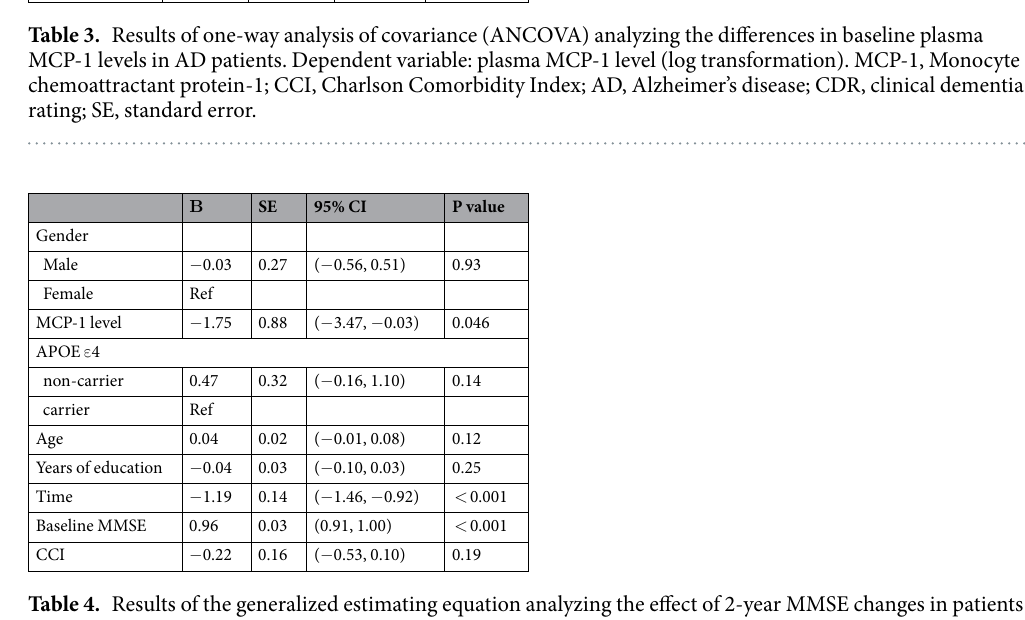
(Supplementary Table 1). Second, Table 4 shows the generalized estimating equation (GEE) analysis of two-year MMSE changes adjusted for age, years of education, gender, time, APOE ε 4 carrier status, baseline MMSE scores, and CCI. The GEE analysis revealed that the baseline MCP-1 level was significantly correlated with the 2-year MMSE changes (B = − 1.75, 95% CI = − 3.47 to − 0.03, p = 0.046). The Genetic Effects of the CCL2 and CCR2 Genotypes on the Plasma MCP-1 Levels. Table 5 shows the distribution of CCL2 and CCR2 genotypes in AD patients, MCI patients, and control subjects. The genotype distributions of CCL2 rs1024611 and CCR2 rs1799864 were in Hardy-Weinberg equilibrium (p = 0.1 and 0.46, respectively). The genotype distributions of these two SNPs were similar among the three patient groups (AD, MCI, and controls), suggesting no association between the CCR2/CCL2 polymorphisms and AD/MCI risk. The average MCP-1 levels were similar among the different genotypes of CCL2 rs1024611 in all groups of participants (Fig. 1, left side). However, the A allele of CCR2 rs1799864 appeared to exert an additive effect on the plasma MCP-1 levels, with the highest levels observed in the AA genotype, followed by the AG genotype, and the lowest levels were observed in the GG genotype (p < 0.001; adjusted p < 0.002, Fig. 1, right side). Table 6